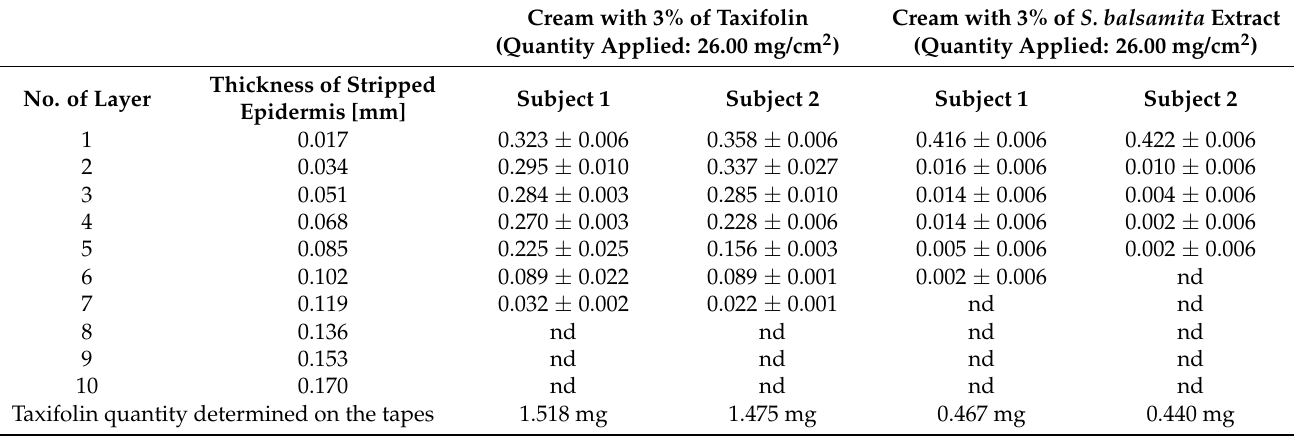
Table 2. The comparison of penetration between the cream with 3% S. balsamita extract and the cream with 3% taxifolin in subsequent layers of the stripped epidermis. cm 2 stripped tapes